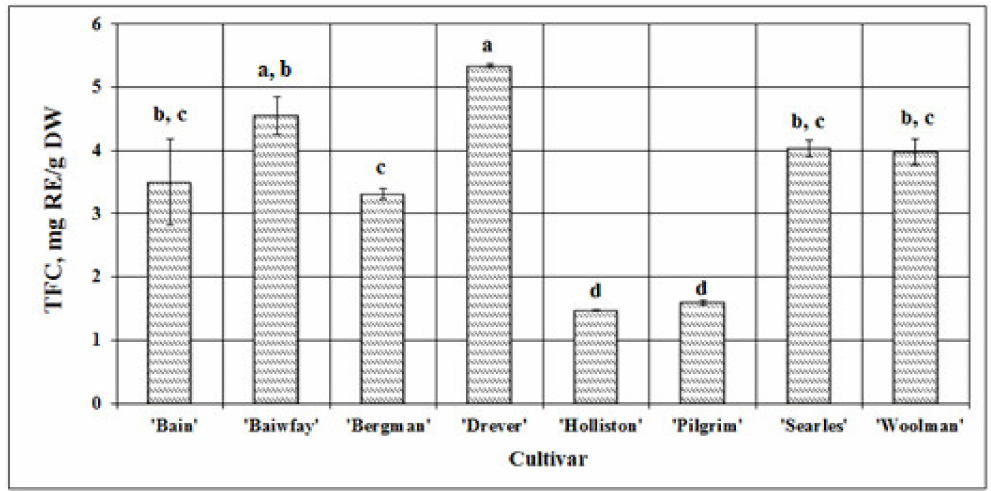
Figure 2. Variability in the total amount of flavonoids (TFC) in fruit samples of di ff erent American cranberry cultivars; di ff erent letters indicate statistically significant ( p < 0.05) di ff erences between the studied cranberry fruit